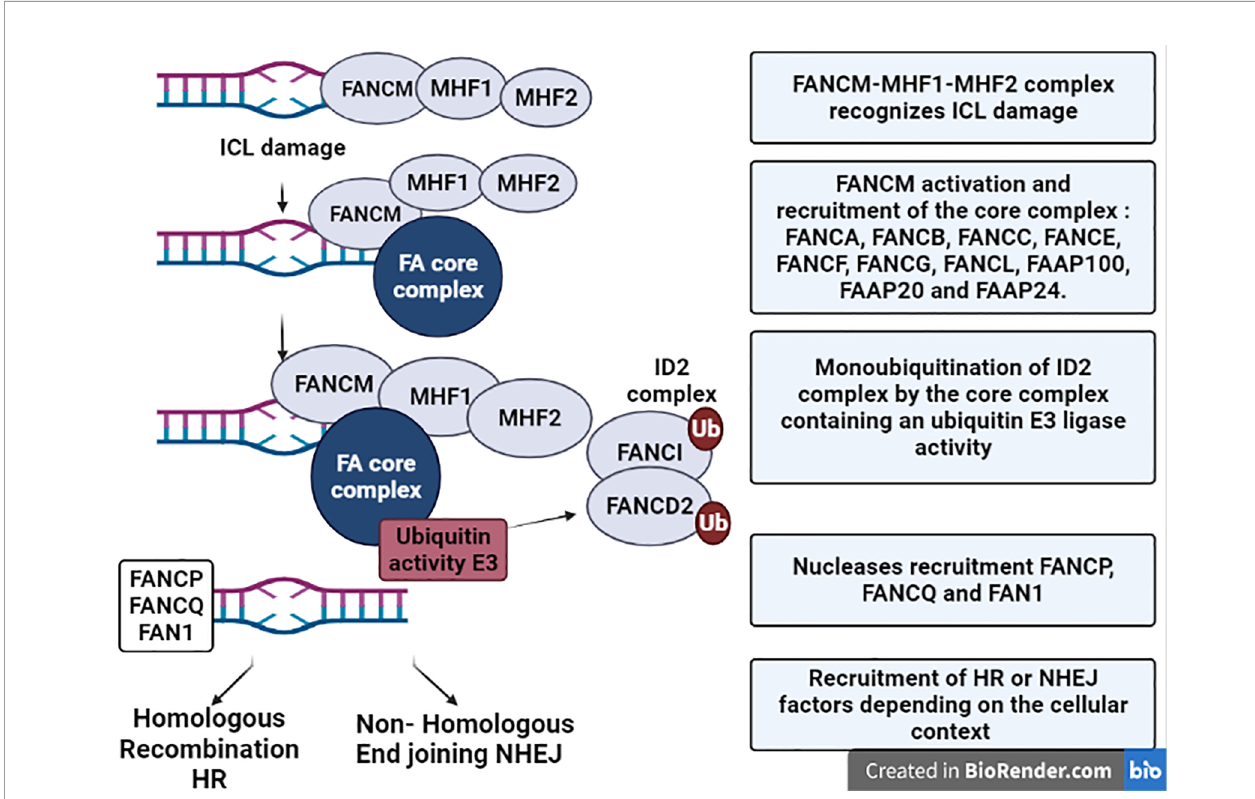
FIGURE 1 | Schematic representation of ICLs repair by the Fanconi Anemia pathway. The protein complex composed of FANCM-MHF1-MHF2 is recruited to the chromatin upon recognition of ICL damage. Then, FANCM is activated and allows the recruitment of the core complex of the FA pathway composed of: FANCA, FANCB, FANCC, FANCE, FANCF, FANCG, FANCL, FAAP100, FAAP20 and FAAP24. The core complex contains an ubiquitin E3 ligase activity and is responsible for the monoubiquitylation of the ID2 complex composed of FANCI and FANCD2 proteins. Monoubiquitinylation of ID2 complex promotes the recruitment of the nucleases FANP, FANCQ and FAN1 and end resection at the DNA damage site. Depending on the cellular context, recruitment of downstream factors belonging to either Homologous Recombination (HR) or to Non-homologous End Joining (NHEJ) will fi nalize the